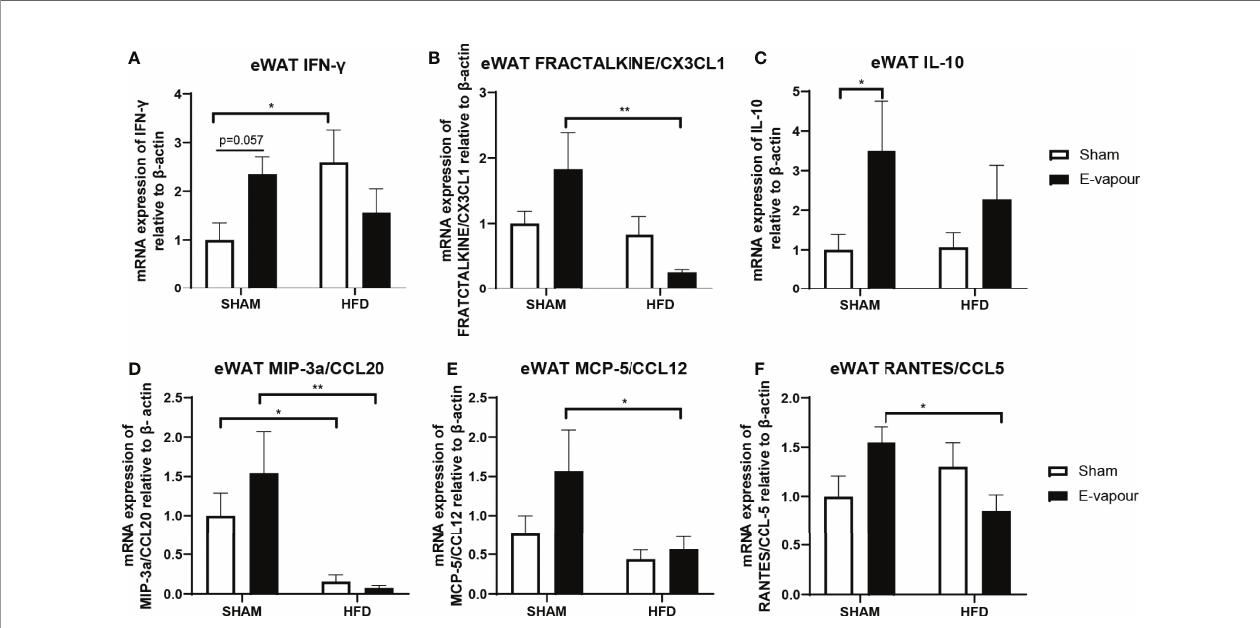
FIGURE 4 | mRNA expression of IFN- g (A) , FRACTALKINE/CX3CL1 (B) , IL-10 (C) , MIP-3a/CCL20 (D) , MCP-5/CCL12 (E) , and RANTES/CCL5 (F) in epididymal white adipose tissue (eWAT). Results are expressed as mean ± SEM, n=7-8. *P < 0.05, **P <